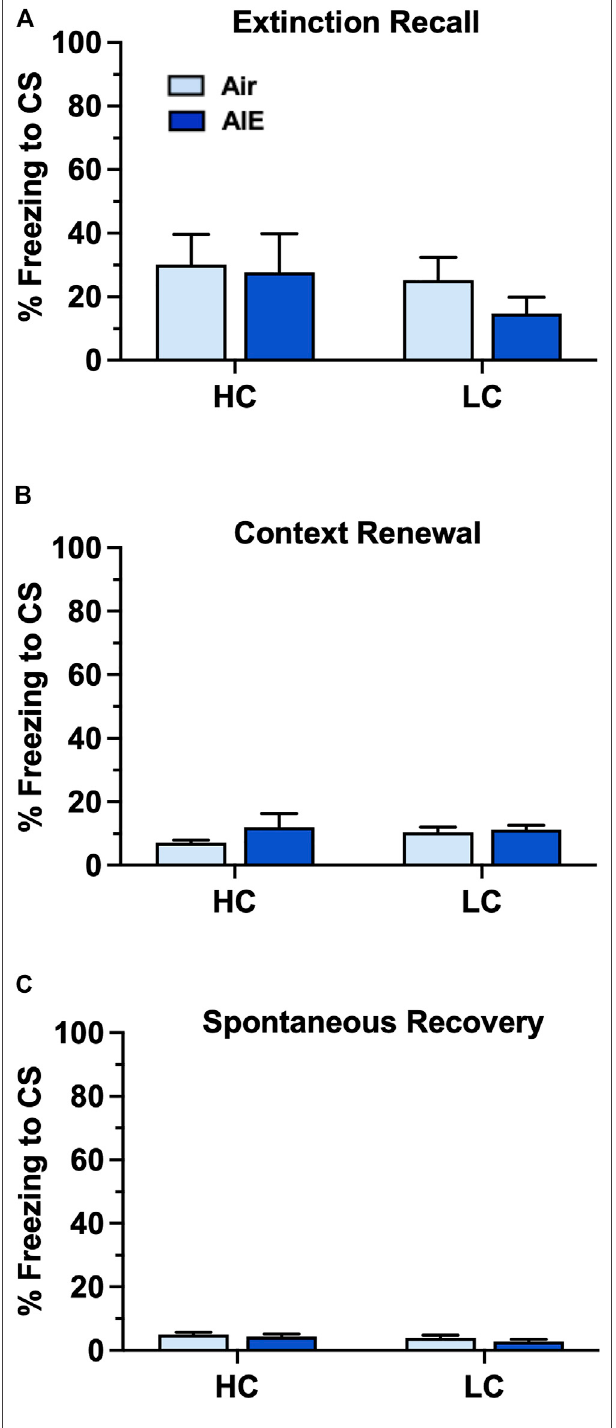
FIGURE 9 | AIE exposure did not alter fear recall, renewal or spontaneousrecovery ineitherhigh conditioning(HC) or lowconditioning (LC) female rats. (A) Following 5 days of extinction training, Air control and AIE exposedadultratsweretestedforextinctionrecallbymeasuringfreezing behavior in response to exposure to a single conditioned tone. This revealed that HC and LC rats exhibited similar levels of freezing during recall, and that AIE exposure had no effect on recall in either HC or LC rats. (B) Following ( Continued )